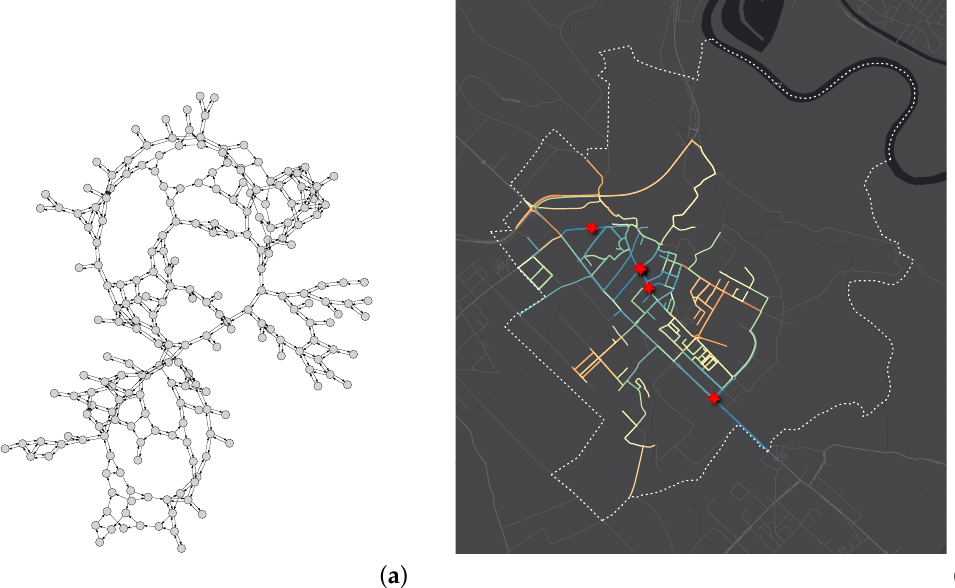
Figure 10. Traffic sensor coverage analysis for the city of Siechnice: ( a ) graph modelling the fol- lows relationships between road fragments; ( b ) existing traffic sensor locations and the resulting measurement